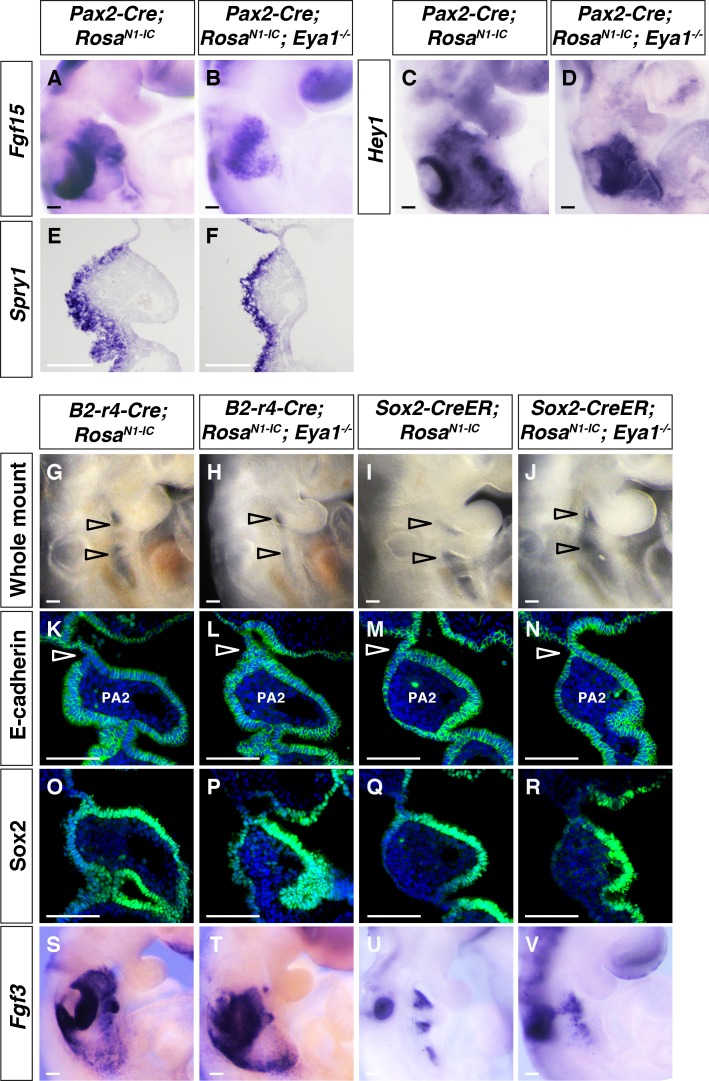
Over-expression of Notch1 ICD by Pax2-Cre, B2-r4-Cre and Sox2-CreER restored pharyngeal segmentation and morphogenesis in Eya1-/- embryos.(A–F) In situ hybridization showing Fgf15, Hey1 and Spry1 expression in Pax2-Cre; RosaN1-IC and Pax2-Cre; RosaN1-IC; Eya1-/- embryos at E9.5 (n = 3). (G–J) Lateral view of Sox2-CreER; RosaN1-IC, Sox2-CreER; RosaN1-IC; Eya1-/-, B2-r4-Cre; RosaN1-IC and B2-r4-Cre; RosaN1-IC; Eya1-/- whole mount embryos at E9.5. Open arrowheads indicate pharyngeal clefts (n = 3). (K–N) Immunostaining for E-cadherin on coronal sections at E9.5 (n = 3). Open arrowheads indicate positions of the pharyngeal clefts. (O–R) Immunostaining for Sox2 on coronal sections at E9.5 (n = 3). (S–V) In situ hybridization showing Fgf3 expression in the pharyngeal ectoderm at E9.5 (n = 4). Scale bars, 100 µm.